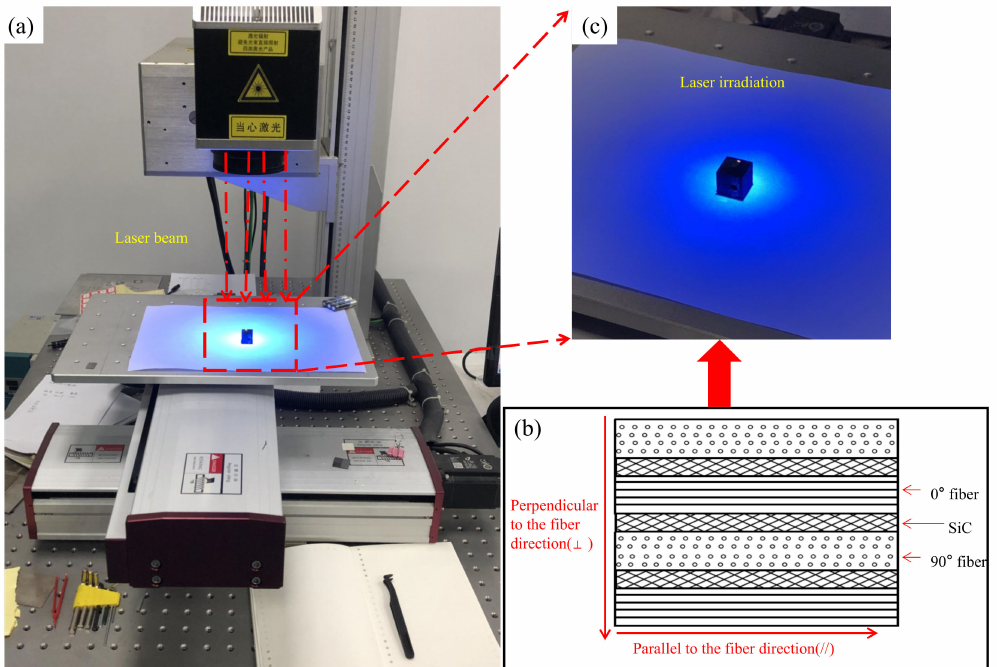
Figure 3. Laser processing of C f /SiC composites (( a ). processing macrograph; ( b ). processing direction diagram; ( c ). pictures during experimental processing).